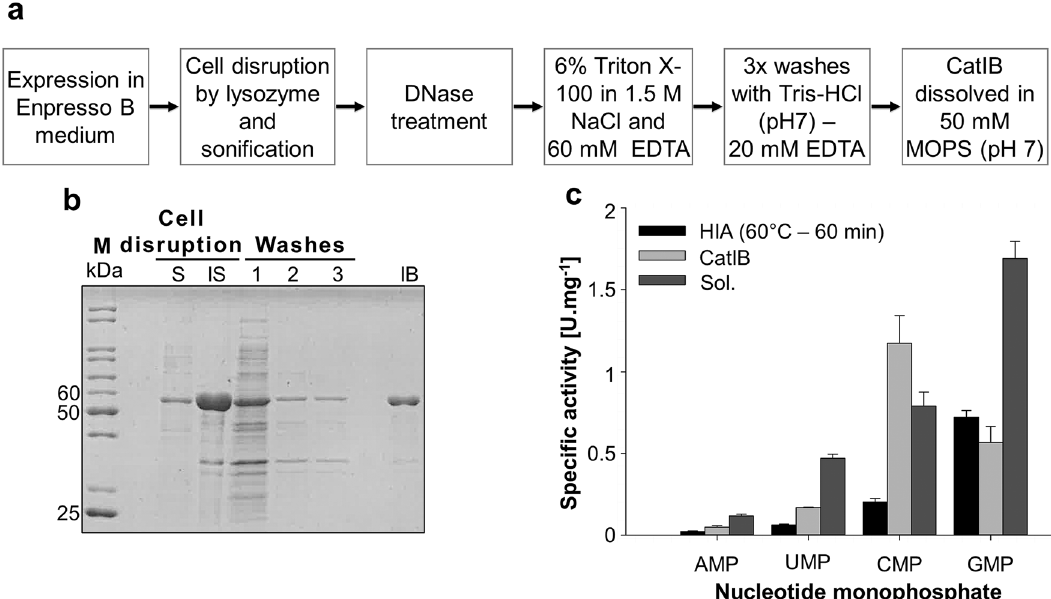
Figure 4. Expression and purification of CatIBs. ( a ) The utilized protocol for IB isolation. ( b ) 12% SDS- polyacrylamide gels showing the different steps of IB isolation. After cell disruption using sonification Tk AMPpase was expressed mainly in the insoluble fraction (IS) (2 µL of 1:10 dilution was used on the gel). Washing steps with Tris–HCl buffer were applied to decrease protein background (10 µL from each (W1, W2 and W3) was loaded on the SDS PAGE). The final IB preparation showed only minor impurities (IB) (2 µL of IB in a 1:16 dilution was loaded on the SDS-PAGE). ( c ) Specific activity of the CatIBs compared to the HIAs obtained from 60 °C heat treatment after 60 min was determined. The used reaction conditions were 2 mM substrate (NMP) and 50 mM potassium phosphate in MOPS buffer (pH 7) at 80 °C. Regular samples were taken at different time points over a period of 15 min. Standard deviation is derived from three experiments. M protein ladder, IS insoluble protein fraction, S soluble protein fraction. Cell disruption method: